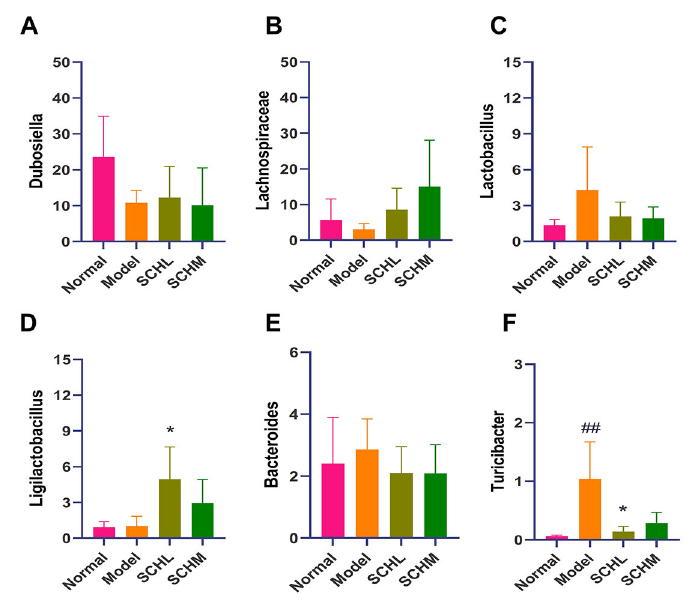
Figure 7. Effect of SCH on the gut microbiota in immunosuppressed mice. The relative abundance of Dubosiella ( A ), Lachnospiraceae ( B ), Lactobacillus ( C ), Ligilactobacillus ( D ), Bacteroides ( E ), and Turicibacter ( F ) in each group. The results are presented as the means ± SD (n ≥ 4). The results are presented as the means ± SD, ## p < 0.01 compared with the normal group, * p < 0.05 when compared with the model group.